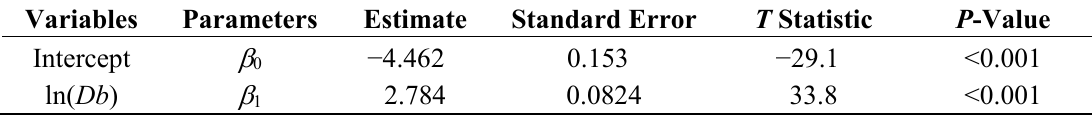
Table 3. Parameter estimates for the simplified allometric equation (Equation (1) log-transformed) to predict the Paulownia resprout biomass (kg of dry mass) according to the basal diameter ( Db ; cm); P -values under 0.05 indicate that the model coefficient differed significantly from 0 (at the 5% level of significance); number of cases: 112 (8 observations with /DFFIT/ > 0.26 were considered influential points and removed).